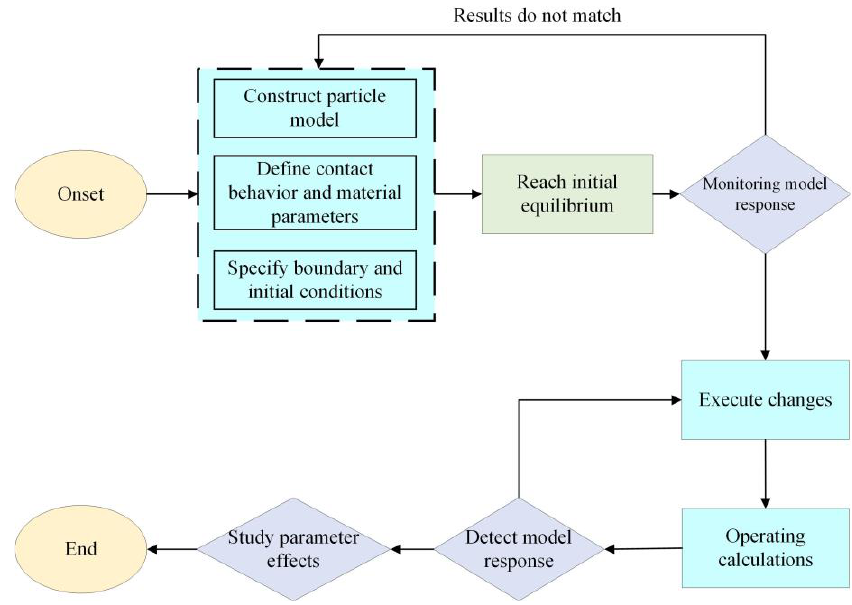
Figure 14. PFC calculation process.